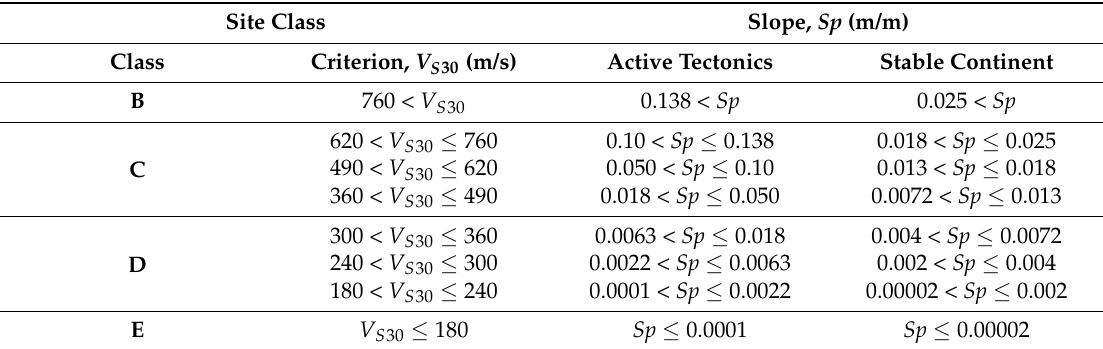
Table 3. Empirical slope range for site classification according to V S 30 of NEHRP (National Earthquake Hazards Reduction Program) [15]